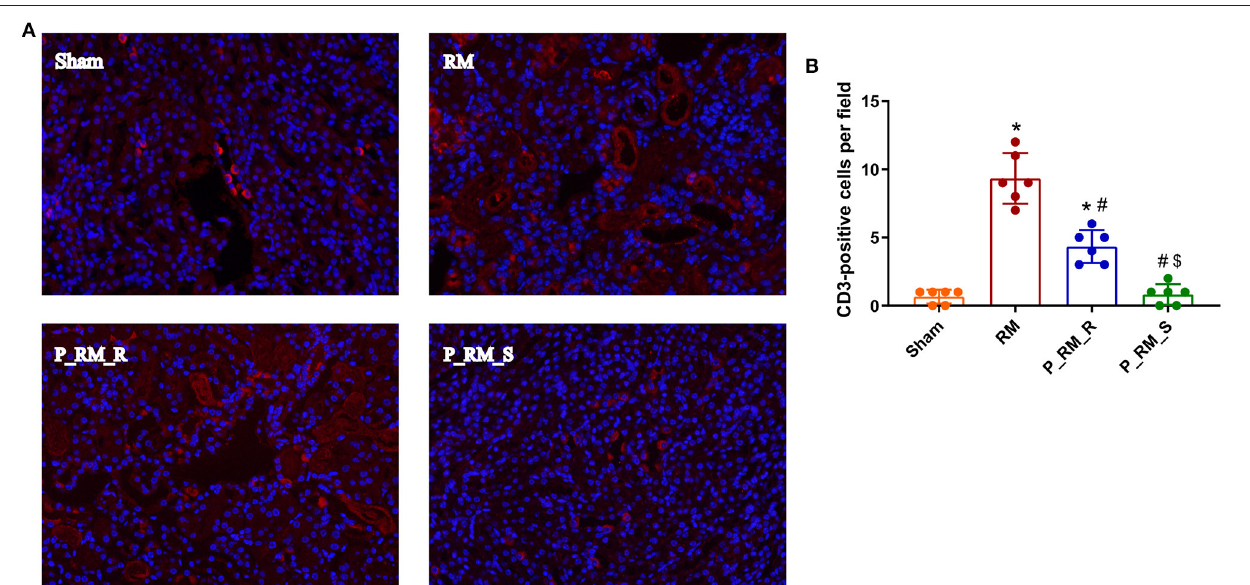
FIGURE 5 | Immunofluorescence staining for C3. (A) Exogenous biological renal support decreased C3 deposition in RM-induced AKI. C3 was deposited along the renal tubular basement membrane in the RM and P_RM_R groups but not in the sham and P_RM_S groups. (B) Percentage of CD3-positive cells. RM, rhabdomyolysis; P_RM_R, the mouse in the parabiosis model administered glycerol; P_RM_S, the other mouse in the parabiosis model supplying the exogenous biological renal support. * P < 0.05 vs. the sham group; # P < 0.05 vs. the RM group; $ P < 0.05 vs. the P_RM_R